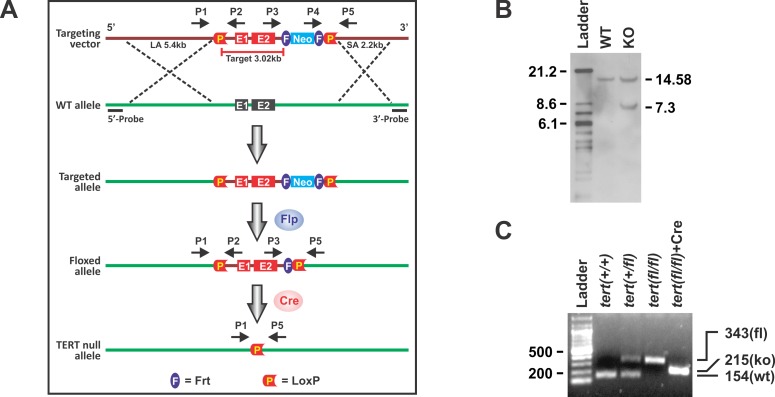
Generation and verification of the TERT CKO mice.(A) Schematic gene-targeting map of TERT gene. The construction of TERT floxed and TERT CKO alleles are shown before and after tamoxifen treatment. TERT gene exon 1–2 was floxed after recombination between WT and targeted alleles. Primers pairs P1/P2 and P3/P5 were used to detect floxed TERT alleles. Primer pair P1/P5 was used to detected the TERT gene excision by Cre. (B) Representative Southern blot analysis. The ES clone with homologous recombination was digested with the restriction enzyme Bsr GI followed by Southern blotting with Dig-labeled 5’ probe as shown in (A). The detected WT and targeted alleles are 14.58 and 7.3 kb, respectively. (C) PCR genotyping using genomic DNA from mouse tails. The PCR fragments for WT was 154bp, for TERT fl/+ they were 154 and 343 bp, for TERT fl/fl it was 343 bp, and for TERT CKO it was 215bp after tamoxifen-induced Cre excision. “Ladder” referred to 100 bp DNA ladder.